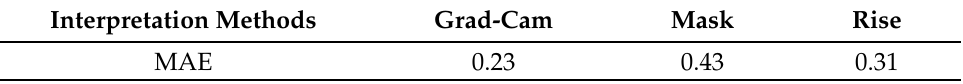
Figure 10. The similarity measure result of the feature importance of different interpretation methods relative to the ground truth value on the DataS data (Police car, Ambulance, School Bus, Tank, Cat, Goat, Panda, Polar Bear, Elephant and Uniform). Table 1. Accuracy results of different interpretation algorithms (the smallest value is the